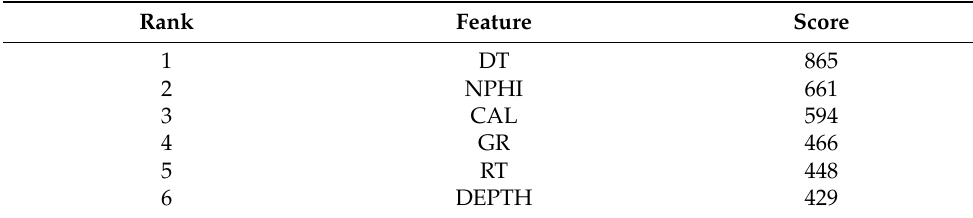
Table 2. Importance scores of the parameters based on the LightGBM model.